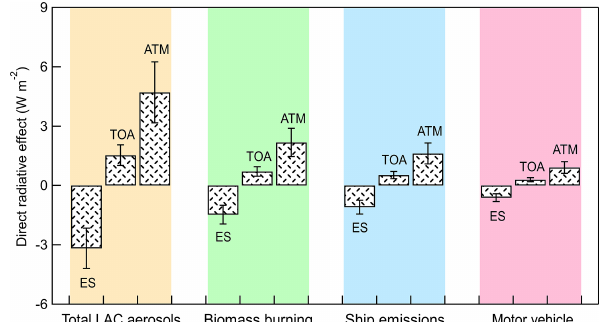
Figure 7. Direct radiative effect (DRE) of light-absorbing carbona- ceous (LAC) aerosols from biomass burning, ship emissions, and motor vehicle emissions. The error bar represents 1 standard devia- tion. ES, TOA, ATM represent the DRE at the Earth’s surface, the top of the atmosphere, and in the atmosphere,